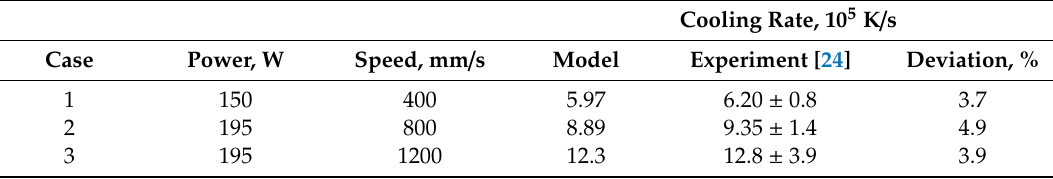
Table 5. Cooling rate model-experiment [24] comparison for IN625 alloy.